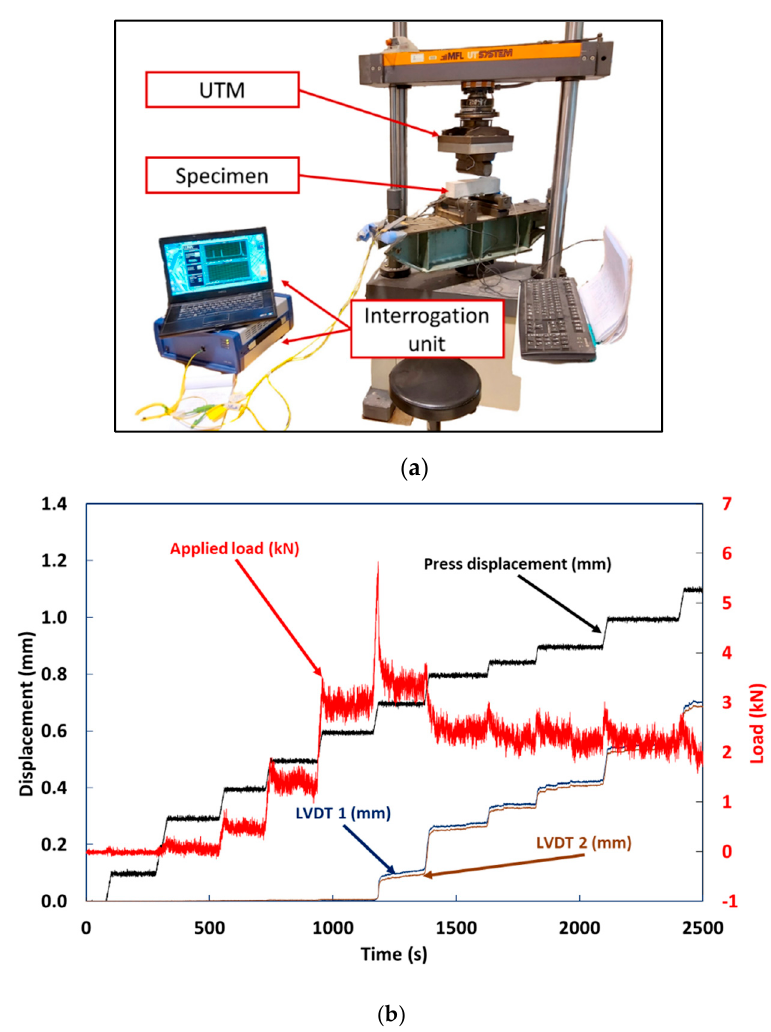
Figure 12. ( a ) Experimental setup used for the bending test; ( b ) recorded time evolutions of the applied load, actuator displacement, and LVDTs displacements.